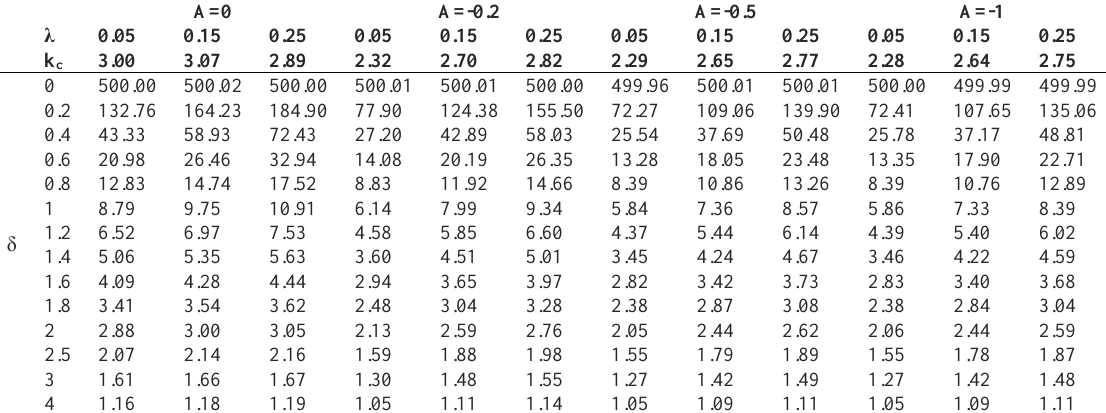
Table 2. ARL zero-state time-varying limit one-sided